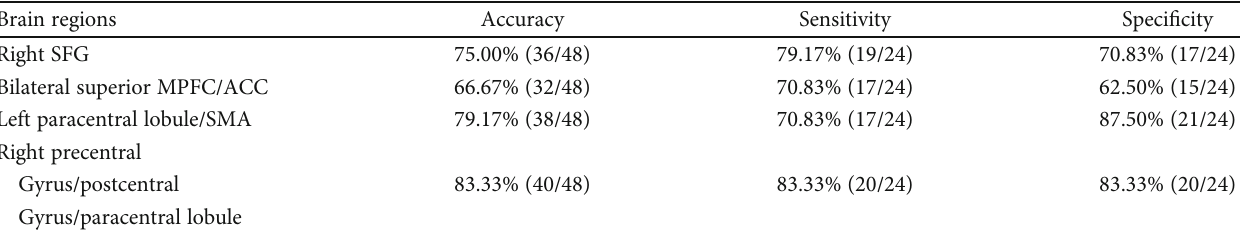
Table 3: Di ff erentiate the patients from the controls by GFC values in each brain region with the SVM method. Brain